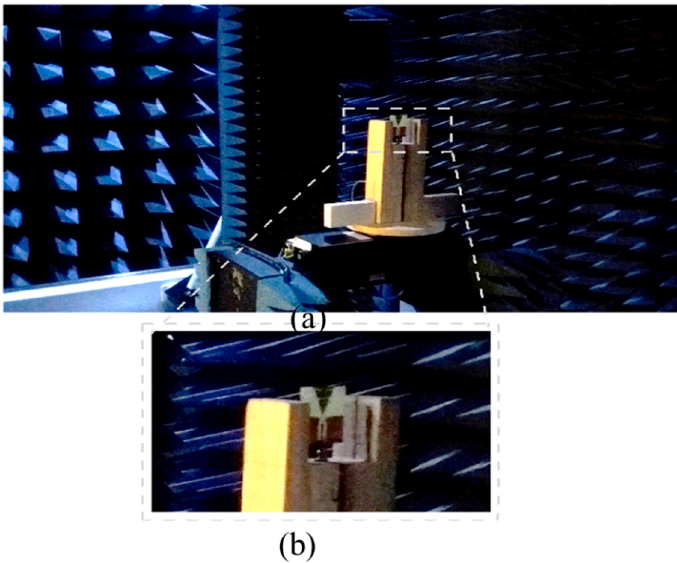
Figure 7. Fabricated prototype of the antenna showing different states.